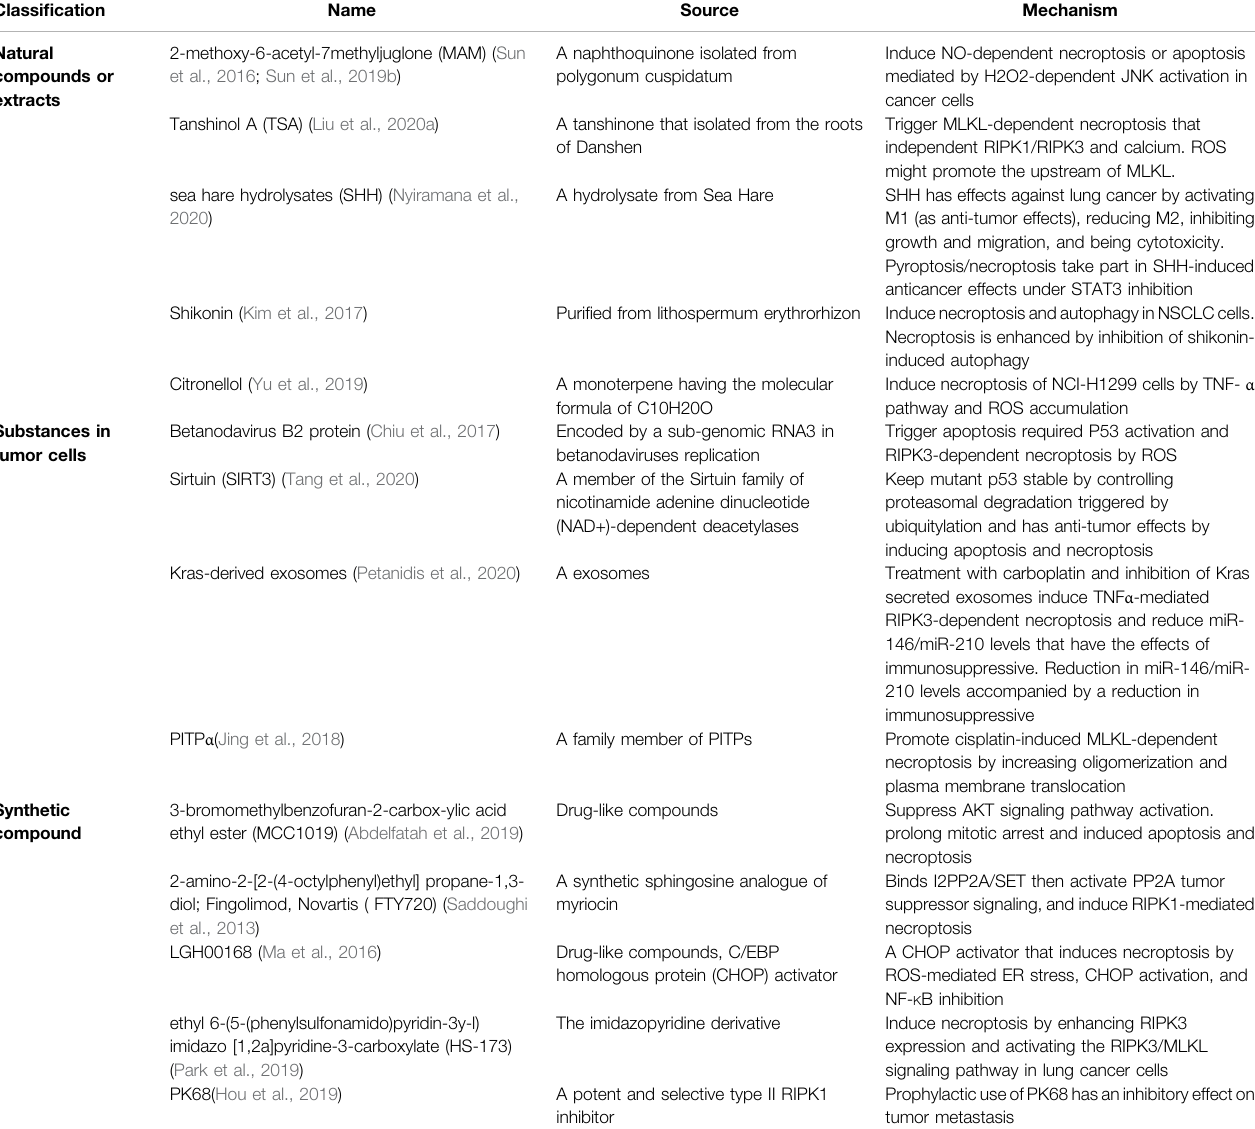
TABLE 2 | Substances that have an inhibitory effect on tumors by mediating